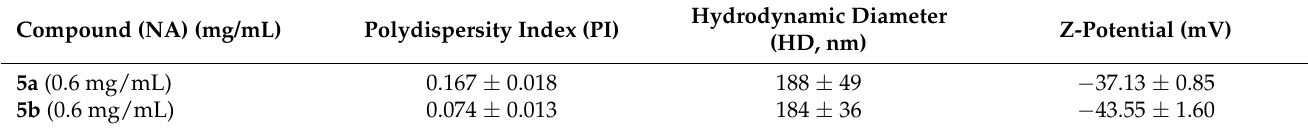
Table 1. NAs 5a, b : structural characterization.